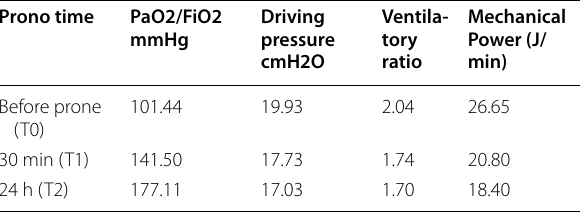
Table 1. Mechanic Ventilatory in the different periods, T0, T1 and